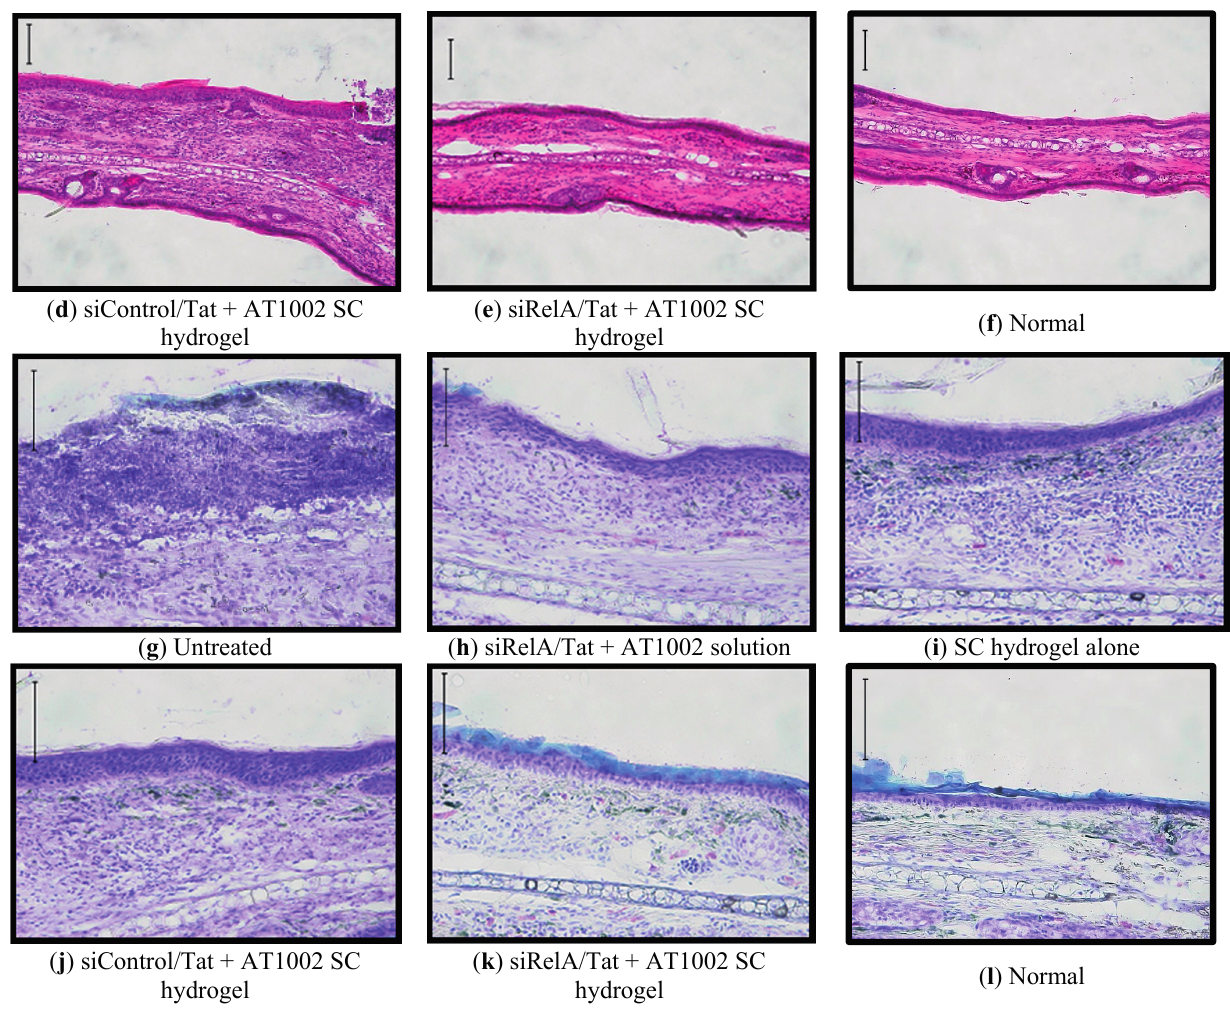
Figure 4. Histological observation of AD-like left ear of model mice after treatment with siRelA containing SC hydrogels. The ear swelling (HE stain, ( a – f )) and infiltration of mast cell (TB stain, ( g – l )) in left ear sections (20 μ m) were observed by an optical microscope. Bar: 100 μ